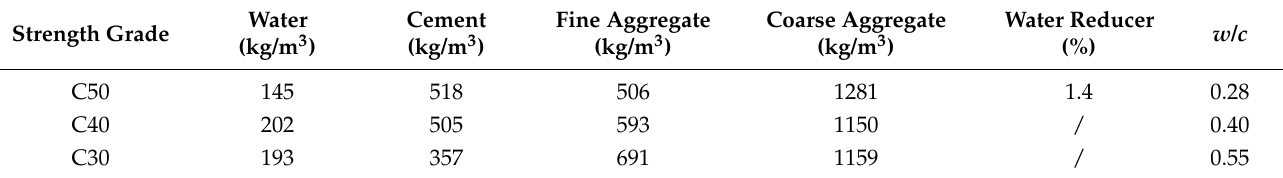
Table 3. Concrete proportion and performance.